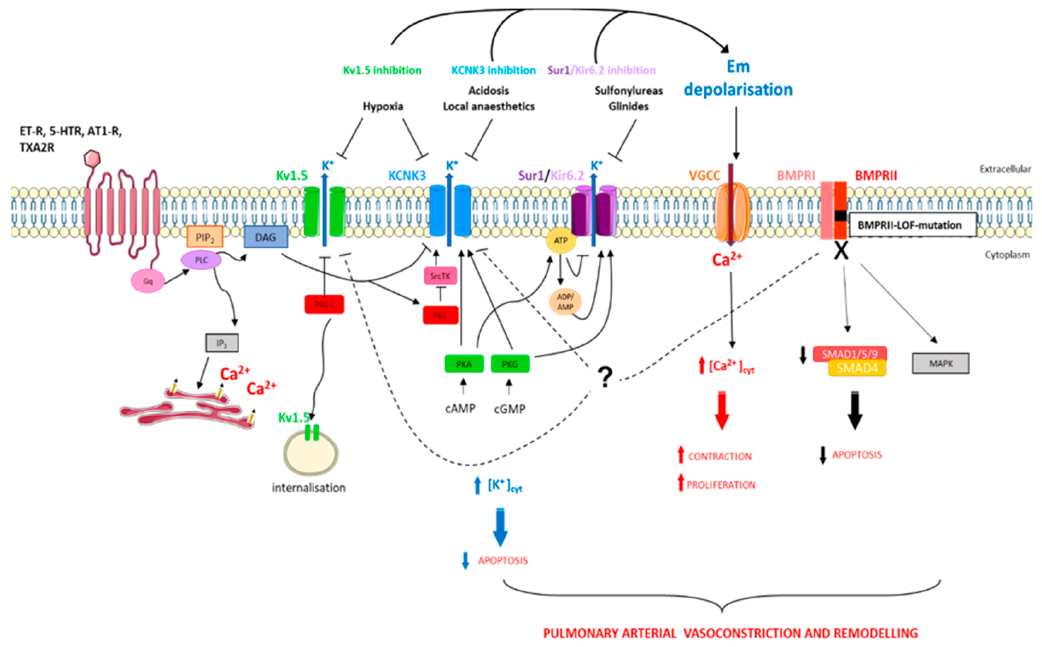
Figure 2. Schematic representation of pathways implicated in K + regulation in pulmonary artery smooth muscle cells in the context of pulmonary arterial hypertension (PAH). [Ca 2+ ] cyt , cytoplasmic calcium concentration; [K + ] cyt , cytoplasmic potassium concentration; 5-HTR, serotonin receptor; AT1-R, angiotensin 1 receptor; BMPRI, BMP receptor type I; BMPRII, BMP receptor type II; cAMP, cyclic adenosine monophosphate; cGMP, cyclic guanosine monophosphate; DAG, diacylglycerol; Em, membrane resting potential; ET-R, endothelin receptor; IP3, inositol-1,4,5-triphosphate; MAPK, mitogen-activated protein kinases; PIP2, phosphatidylinositol-4,5-biphosphate; PKA, protein kinase A; PKC, protein kinase C; PKG, protein kinase G; PLC, phospholipase C; SMAD, mothers against decapentaplegic homologue; SrcTK, Src family tyrosine kinase; TXA2R, thromboxan A2 receptor.